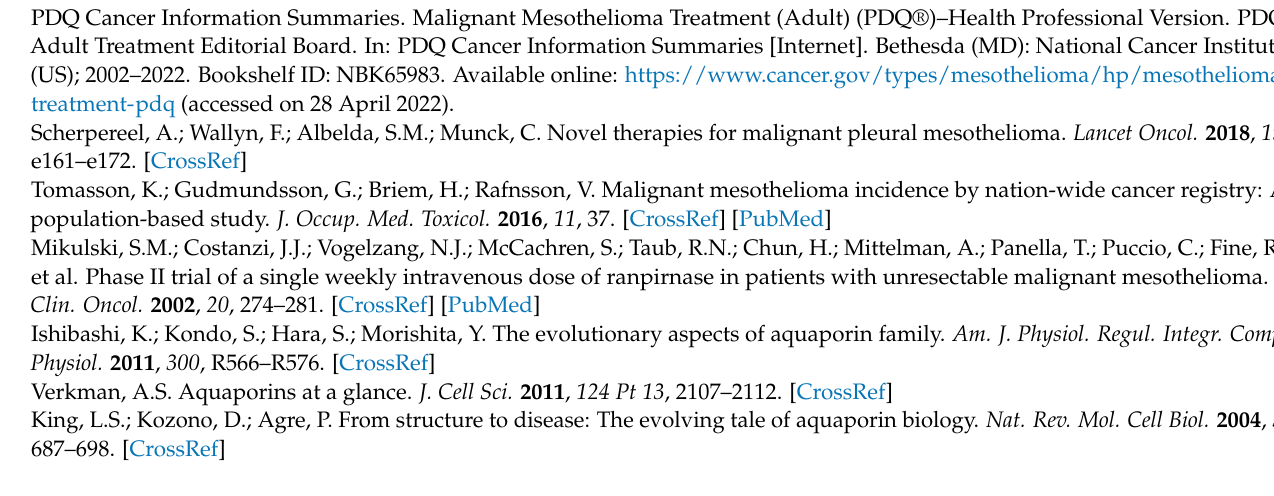
Figure S4: Representative curve of stopped-flow osmotic permeability measurement obtained from MeT-5A cell line; Figure S5: AQP6 silencing in mesothelial (A) (MeT-5A), (B) epithelioid (REN), and (C) biphasic (MSTO-211H) MPM cells; Figure S6: qRT-PCR reaction analysis of AQP1, AQP2, AQP3, AQP4, AQP5, AQP7, AQP8, AQP9, AQP10, and AQP11 expression in MSTO-211H cell line silenced for AQP6 (siRNA) and mock-transfected (Ctr); Figure S7: Effect of AQP3 (A) and AQP5 (B) silencing on water permeability of MeT-5A, REN, and MSTO-211H cells; Figure S8: Effect of acid pH on water permeability of MeT-5A, REN, and